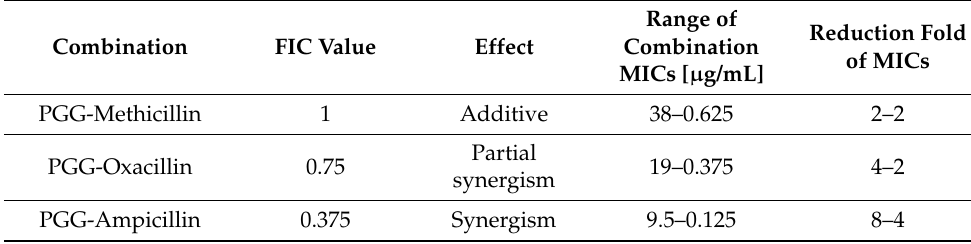
Table 2. Antibacterial effect of PGG combined with antibiotics